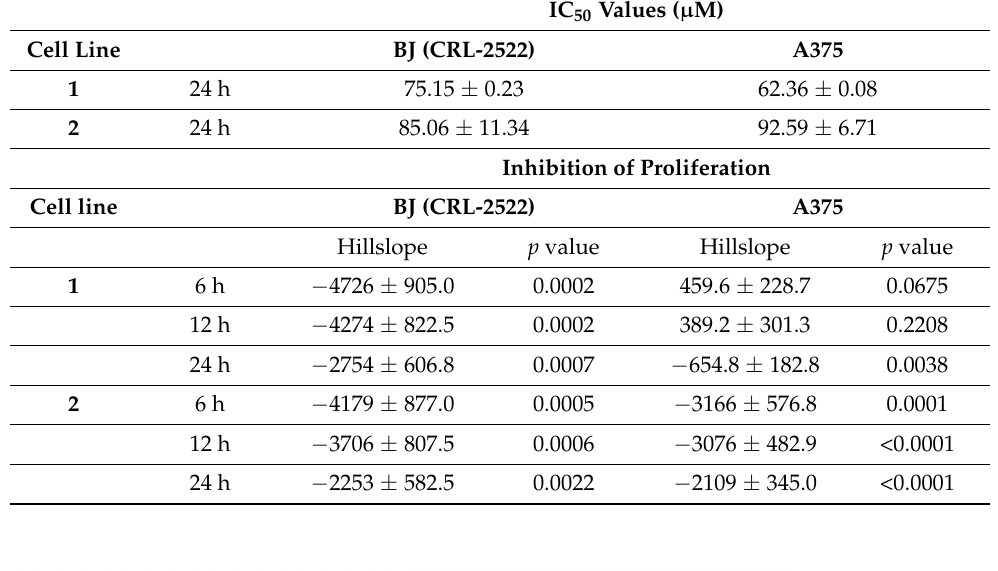
Table 2. The cytotoxicity of zeaxanthin-rich extracts 1 and 2, expressed as half inhibitory concentration (IC 50 , sigmoidal dose-response) and the antiproliferative capacity expressed as significant negative hillslope derived from the linear regression of time-dependent inhibition.